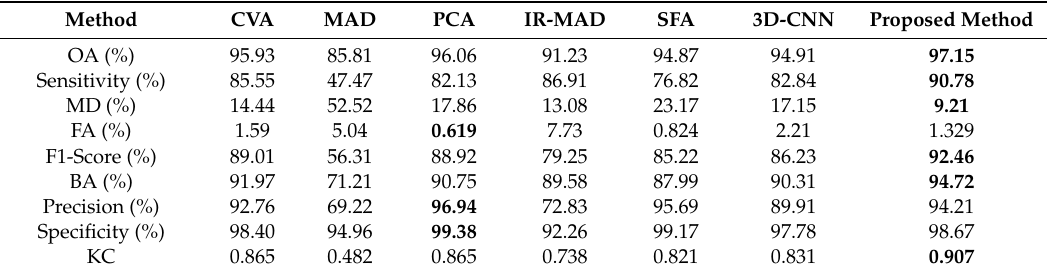
Table 11. The accuracy of the different change detection methods applied to the Hyperspectral-Farmland dataset (the best performance for each method appears in bold).